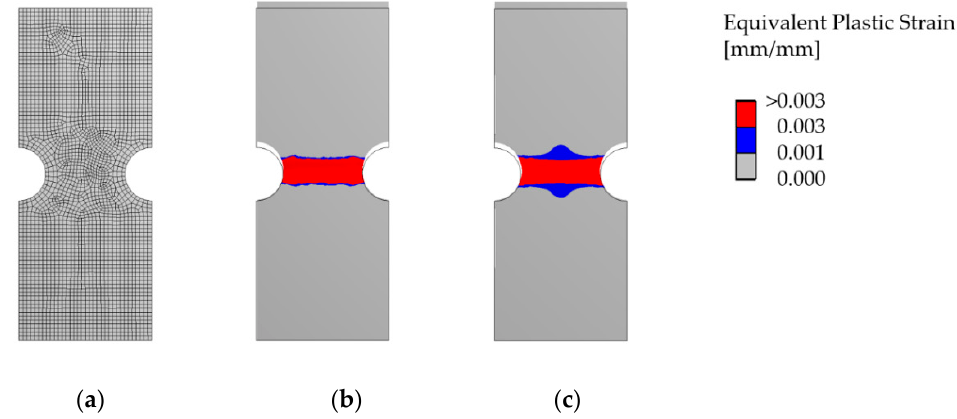
Figure 11. Failure mechanisms (equivalent plastic strain) from a FEA for the tensile specimen with notches: ( a ) Mesh; ( b ) yield surface according to the T resca criterion was used; ( c ) yield surface according to the M ises criterion was used.